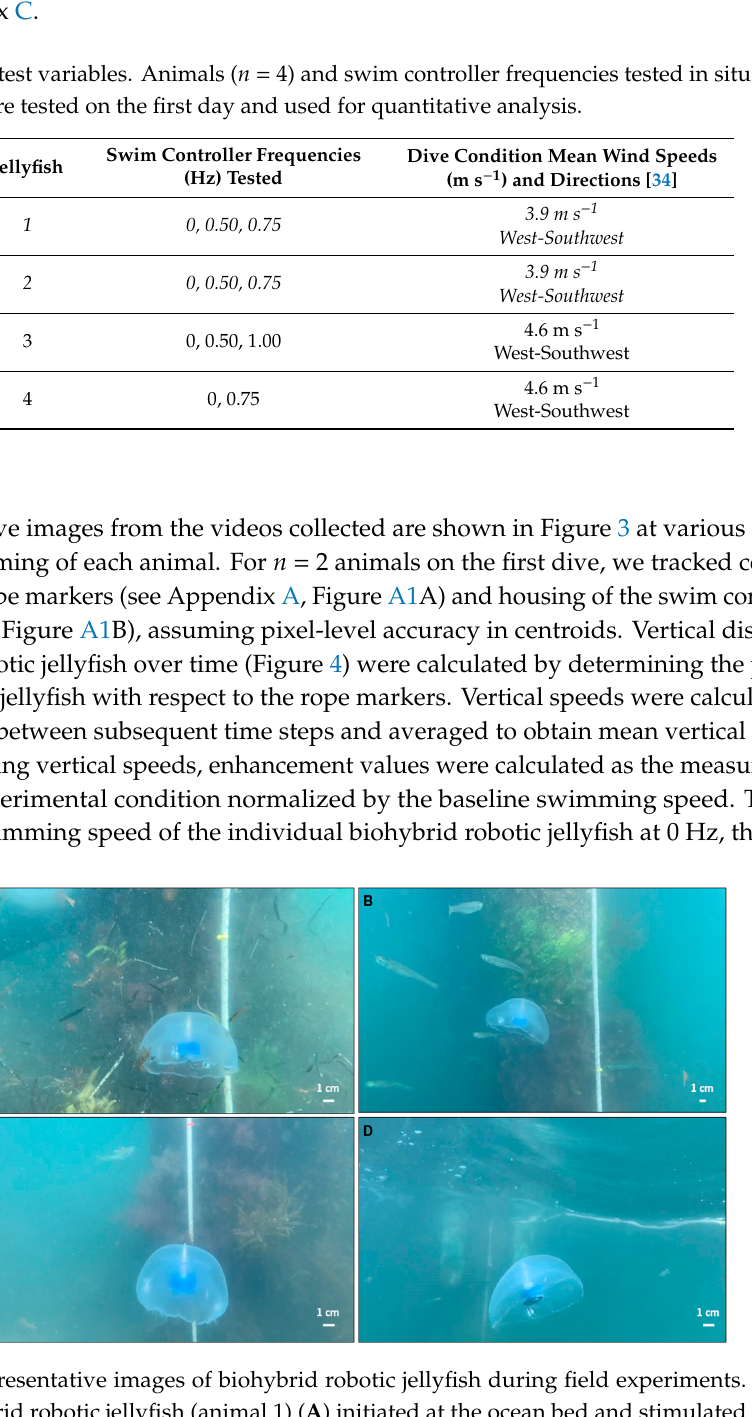
Table 1. Field test variables. Animals ( n = 4) and swim controller frequencies tested in situ. Italicized conditions were tested on the first day and used for quantitative analysis.